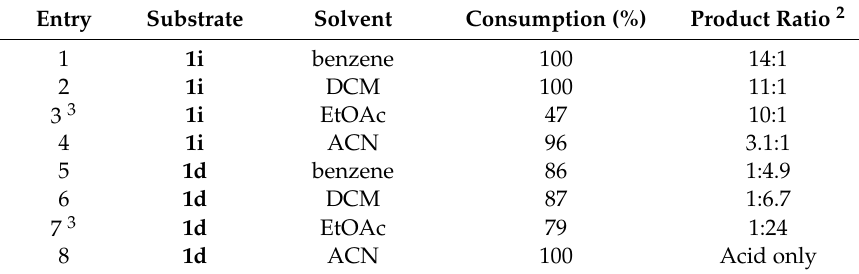
Table 2. Influence of the solvent on the distribution of the reaction products 1